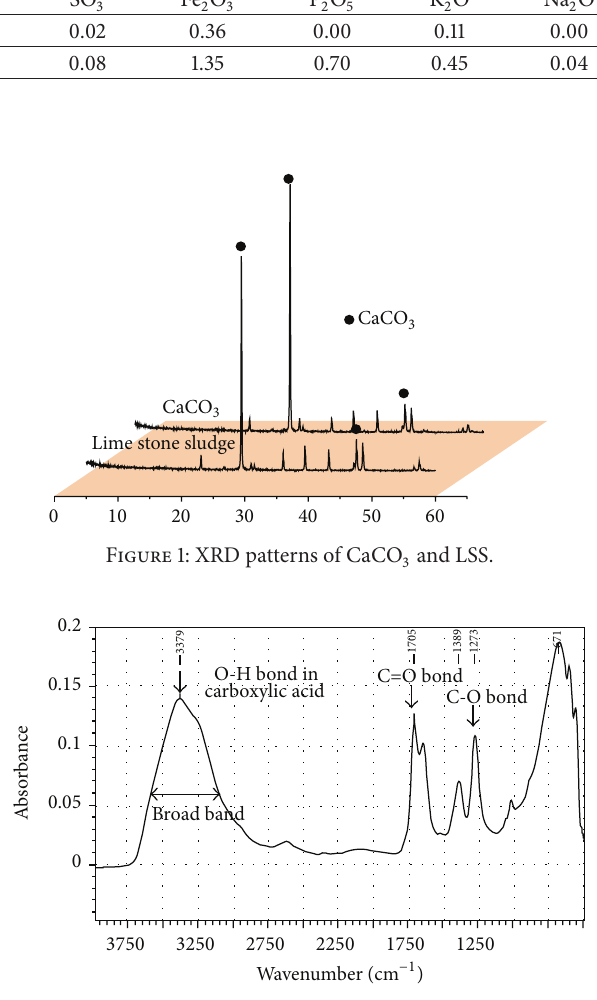
Figure 2: FT-IR spectrum of